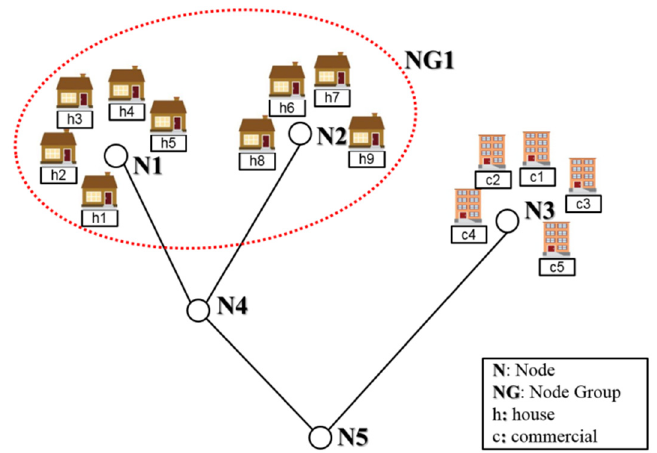
Figure 1. Residential and commercial demands represented as nodes in a hydraulic WDS model. The dashed ellipse shows a potential node group.